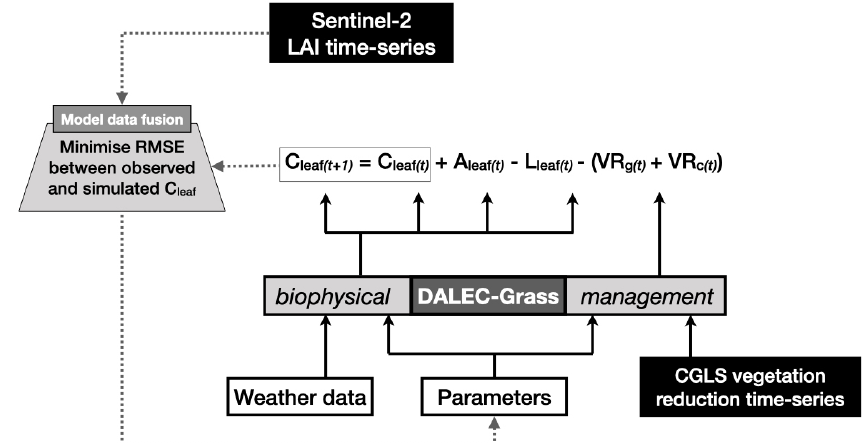
Figure 3. Description of how S2 LAI observations, (CGLS) vegetation reduction time series, and DALEC-Grass are used to infer and calcu- late managed vegetation removals (grazing, cutting). The DALEC-Grass biophysical module simulates weekly leaf growth and senescence driven by weather data. The DALEC-Grass management module simulates weekly vegetation removals driven by the vegetation reduction data. The CARDAMOM MDF algorithm calibrates the parameters of DALEC-Grass in order to achieve the smallest possible error (RMSE) between S2 LAI and simulated LAI time series. LAI = C leaf / P15 (see Table A1 for details on parameter P15). The DALEC-Grass manage- ment module determines whether LAI reduction is due to grazing ( L g ) or cutting ( L c ) or neither. When a grazing reduction is identified (VR g > 0 thus VR c = 0) the livestock C-turnover process (described in Sect. 2.1.2) is implemented. When a reduction is identified as pro- duced by cutting (VR c > 0 thus VR g = 0), most leaf biomass is removed; parameters P27, P28, P29 and P31 (Table A1) play a direct role in cut yield estimation. When neither grazing nor cutting is identified, then VR c = 0 and VR g = 0. Boxes in black show EO-based information. C leaf : leaves C pool; A: C allocation; L: litter production; VR g : vegetation removal due to grazing; VR c : vegetation removal due to cutting; t :